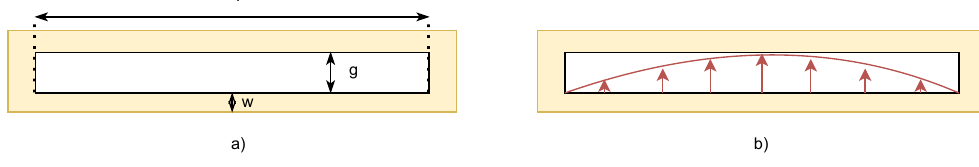
Figure 2. ( a ) Schematic of the loop-sensing resonator. The nanowires are deposited in the center of the gap since it is the spot with the highest E field. ( b ) Illustration in red of the E field concentrated in the loop gap at the